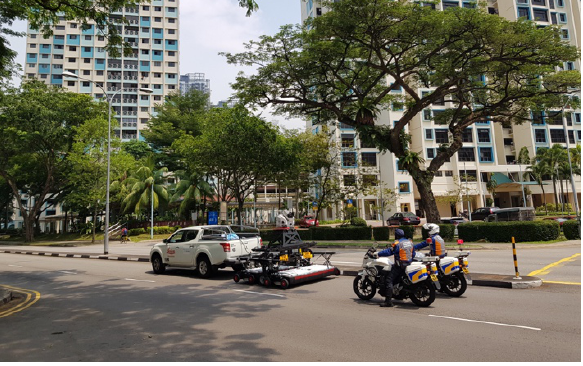
Figure 1. Data capture in Toa Payoh, Singapore.